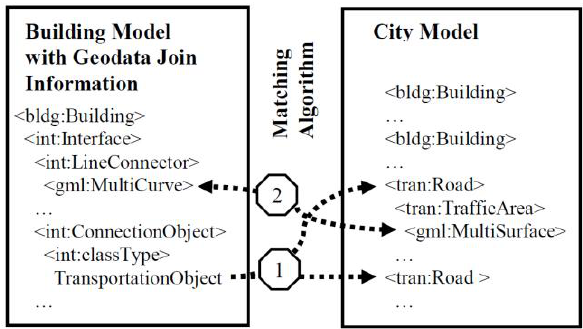
Figure 4. Schematic representation of the matching algorithm including the two steps